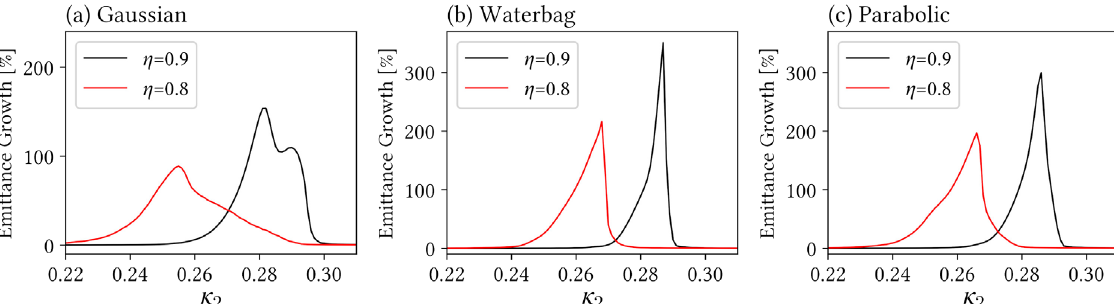
FIG. 9. Stop-band configurations after beam transport over 200 sinusoidal focusing cells. The bare tunes have been fixed to 0.15 in both transverse directions ð ν 0 ¼ 0 . 15 Þ . The external linear perturbation of the driving tune κ 2 is applied to excite the coherent quadrupole mode. The perturbation amplitude is set at 0.4% of the focusing field ’ s. The ordinate represents the average transverse rms emittance growth at the 200th cell, plotted as a function of κ 2 . Three different types of initially matched distributions with η ¼ 0 . 8 and 0.9 are considered: (a) Gaussian, (b) waterbag, and (c)